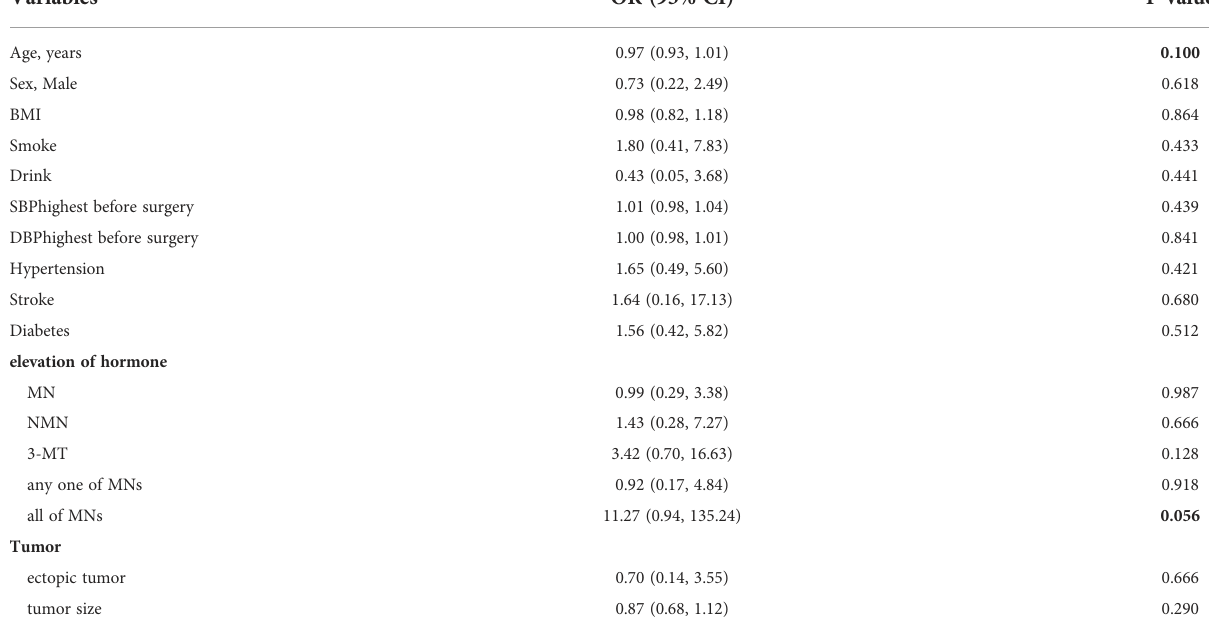
TABLE 2 Results of univariate